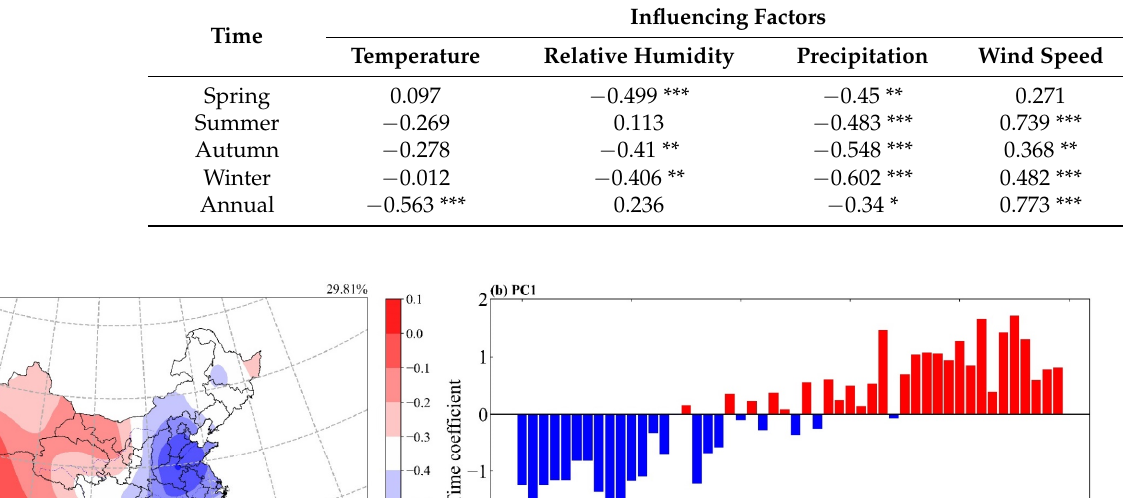
Table 2. Correlation coefficient between annual and seasonal SD and influencing factors (*, ** and *** refer to passing the p < 0.05, p < 0.01 and p < 0.001 significance tests, respectively).